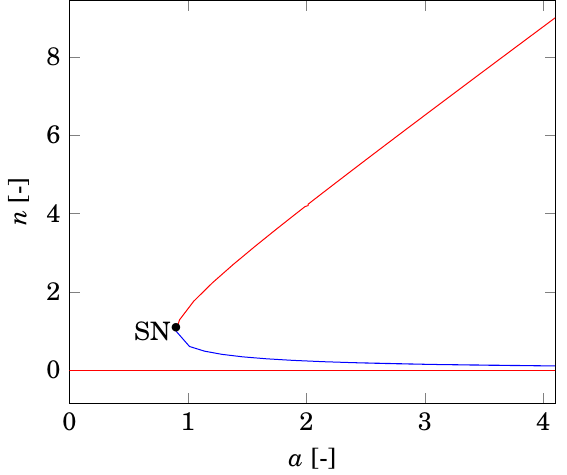
Figure 1. The bifurcation diagram for the control parameter a with m = 0.45 is shown. SN indicates the saddle-node bifurcation point. Red lines indicate stable equilibria, while the blue line indicates unstable